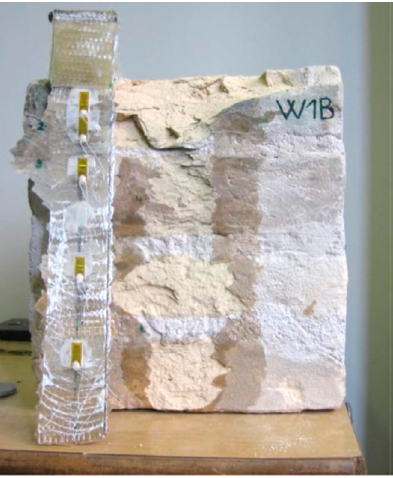
Figure 1. Typical delamination failure of GFRP strip-to-historic-brickwork joint [3]. Reprinted from Composite Structures, 140, Capozucca R., Ricci V., Bond of GFRP strips on modern and historic brickwork masonry, 540–555, Copyright (2016), with permission from Elsevier.